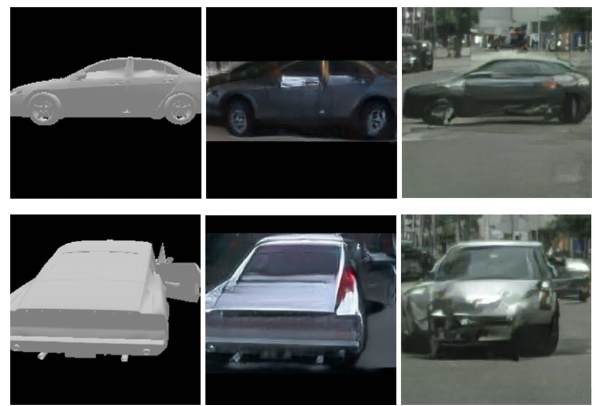
Figure 5. Rendered ShapeNet models (left) with CycleGAN texture (middle) pix2pixHD texture